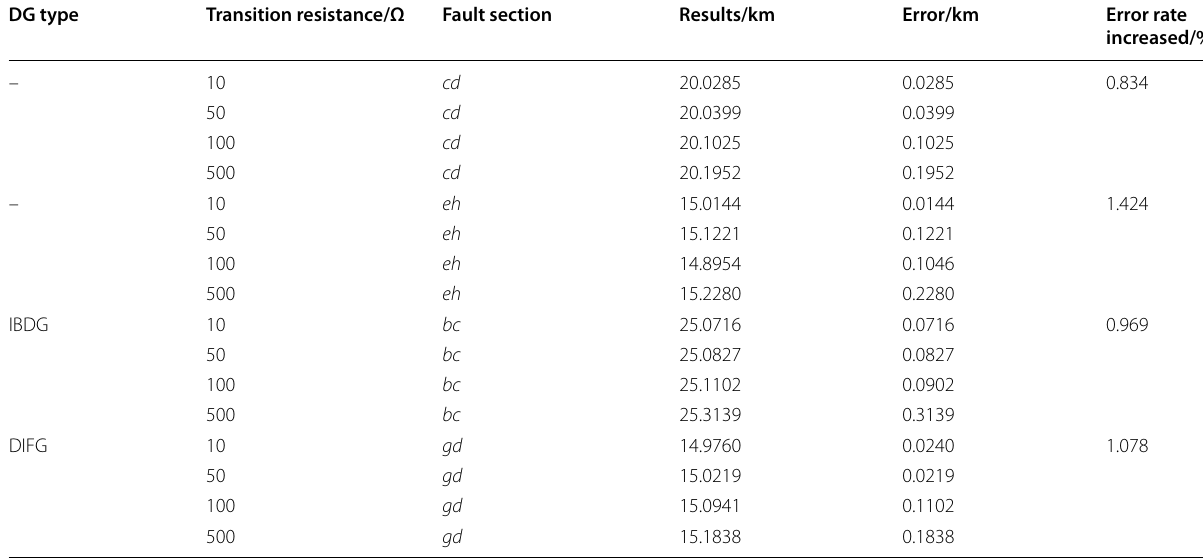
Table 4 Simulation results of fault location with different transition resistances DG type